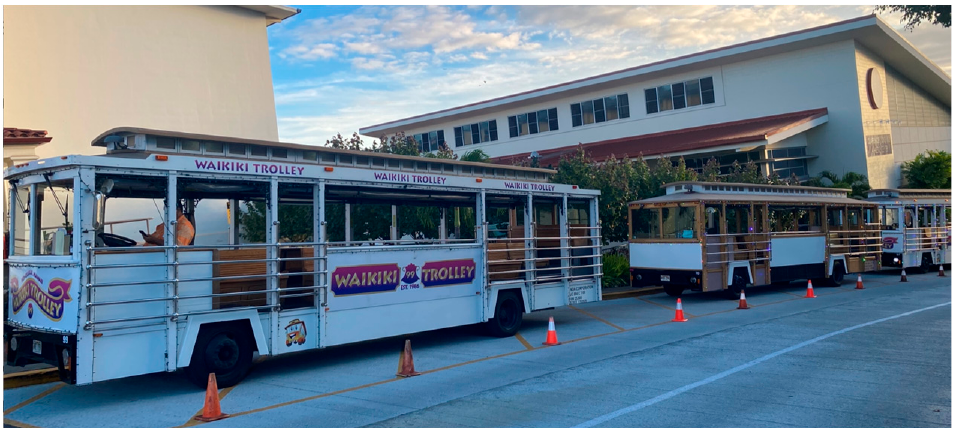
Figure 1. Waikiki trolley buses at the depot.